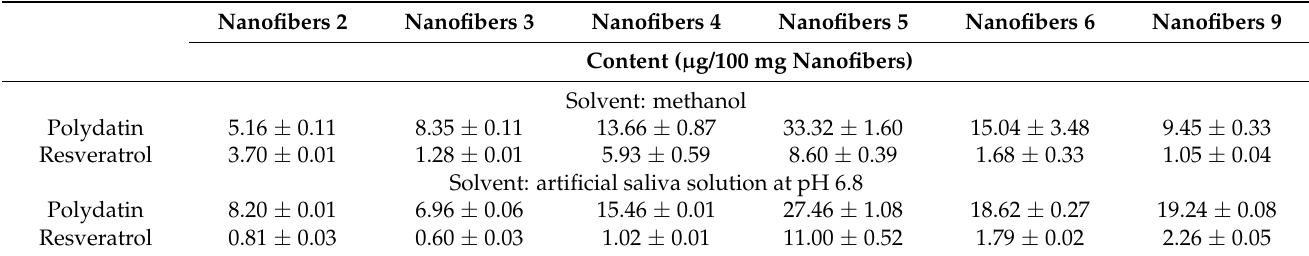
Table 6. Content of Active Components in Nanofibers.